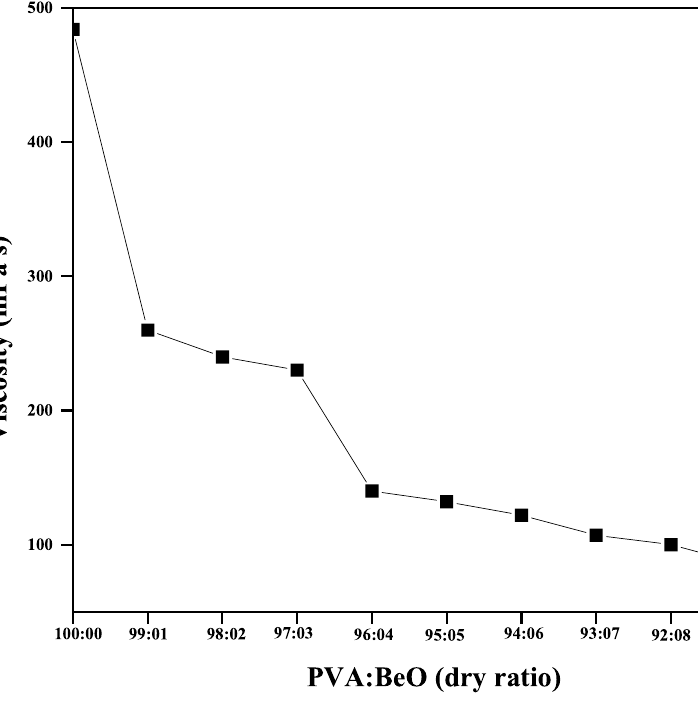
Fig. 2 Effect of BeO contents on the viscosity of PVA/BeSO